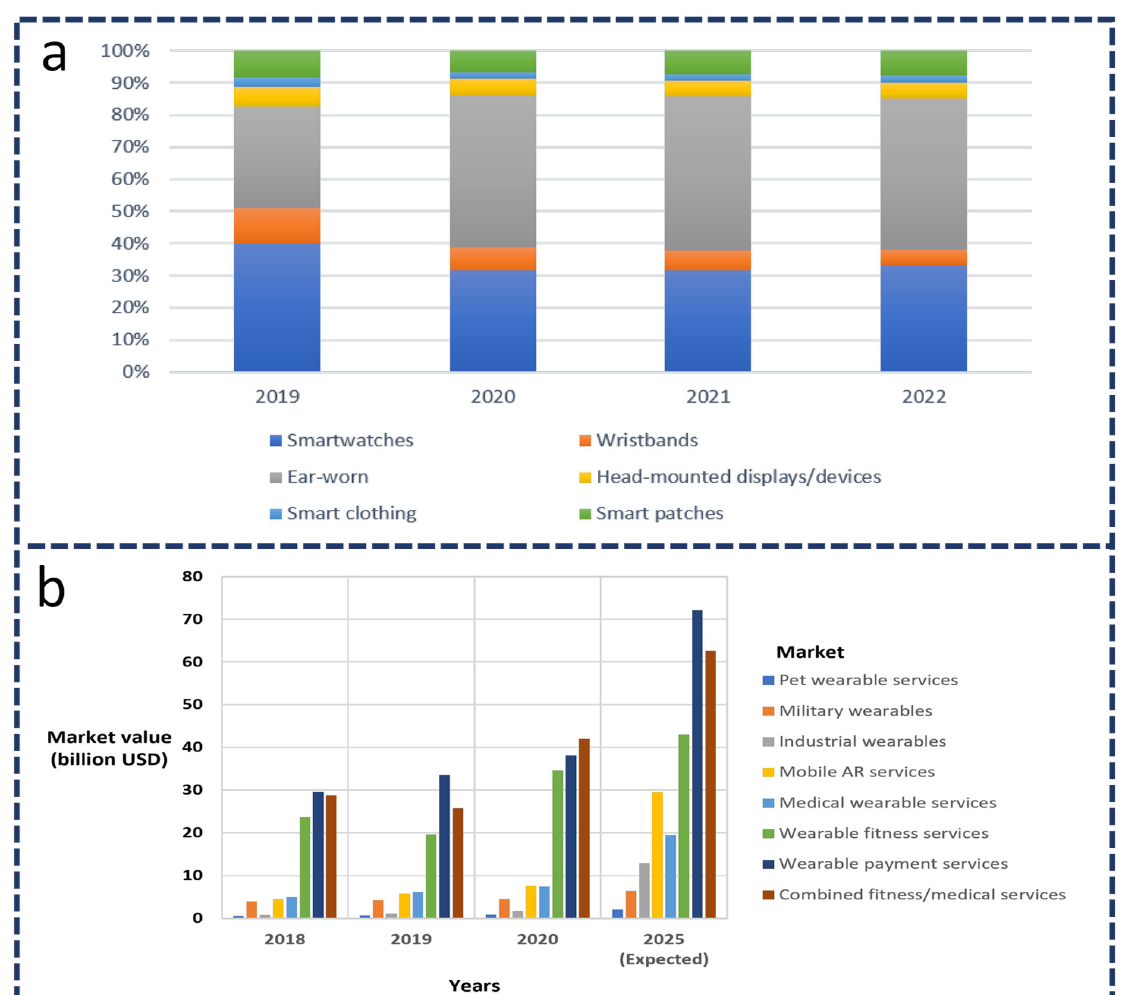
Figure 1. ( a ) Global market share of wearables devices for consumers from 2019–2022; ( b ) wearable services market ‐ value images. Reproduced with permission from MDPI (2021) [2].